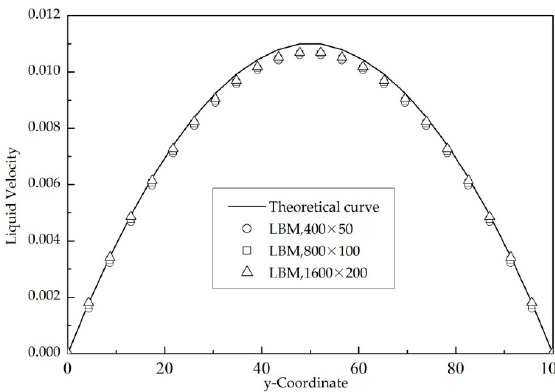
Figure 5. Comparison of the numerical velocity profile and the theoretical solutions.